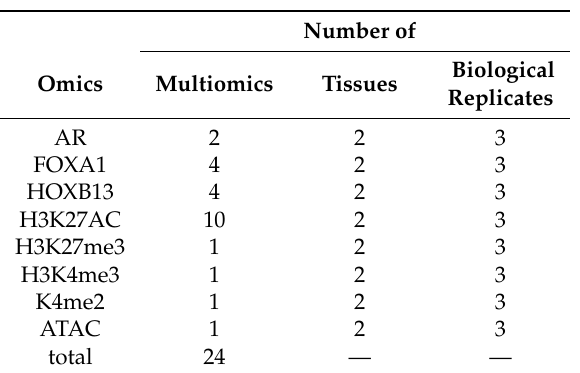
Table 2. Sumary of real